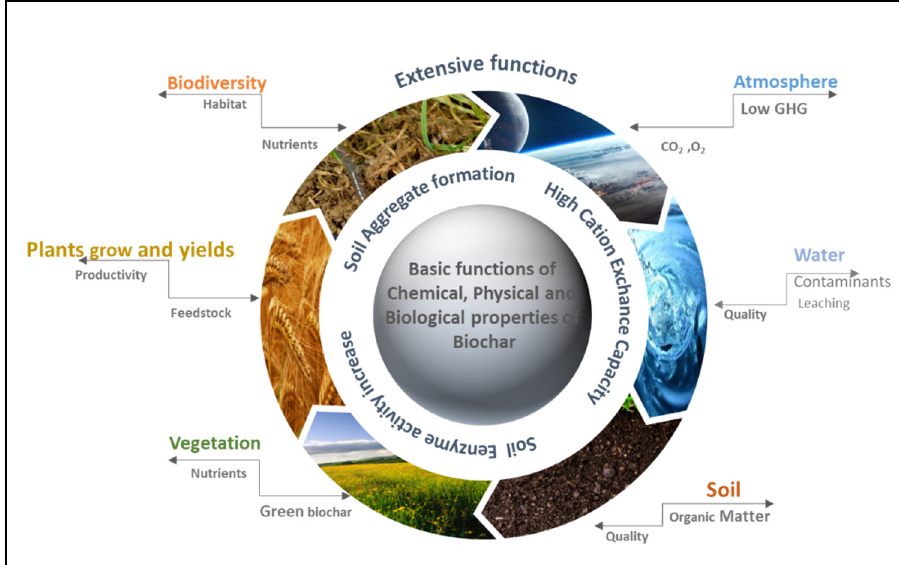
Figure 3. Environmental benefits of biochar.